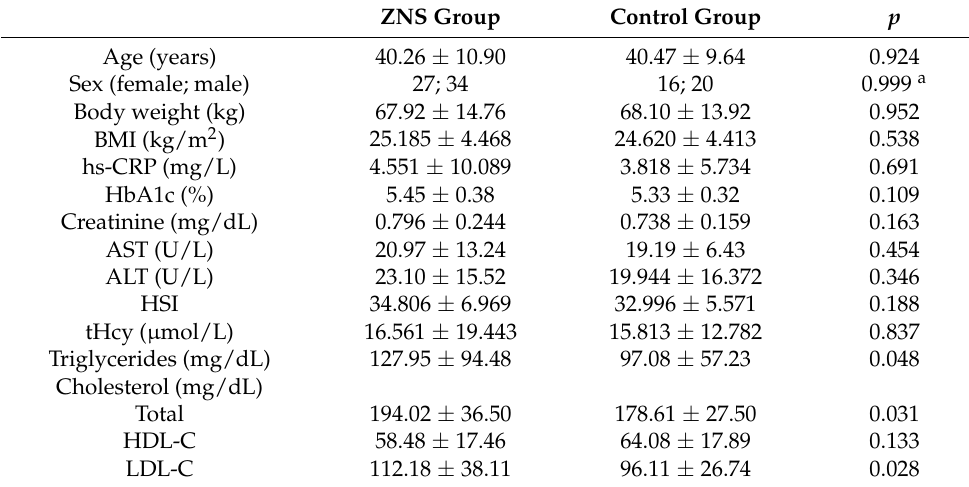
Table 1. Comparison of ZNS-treated and control patients at